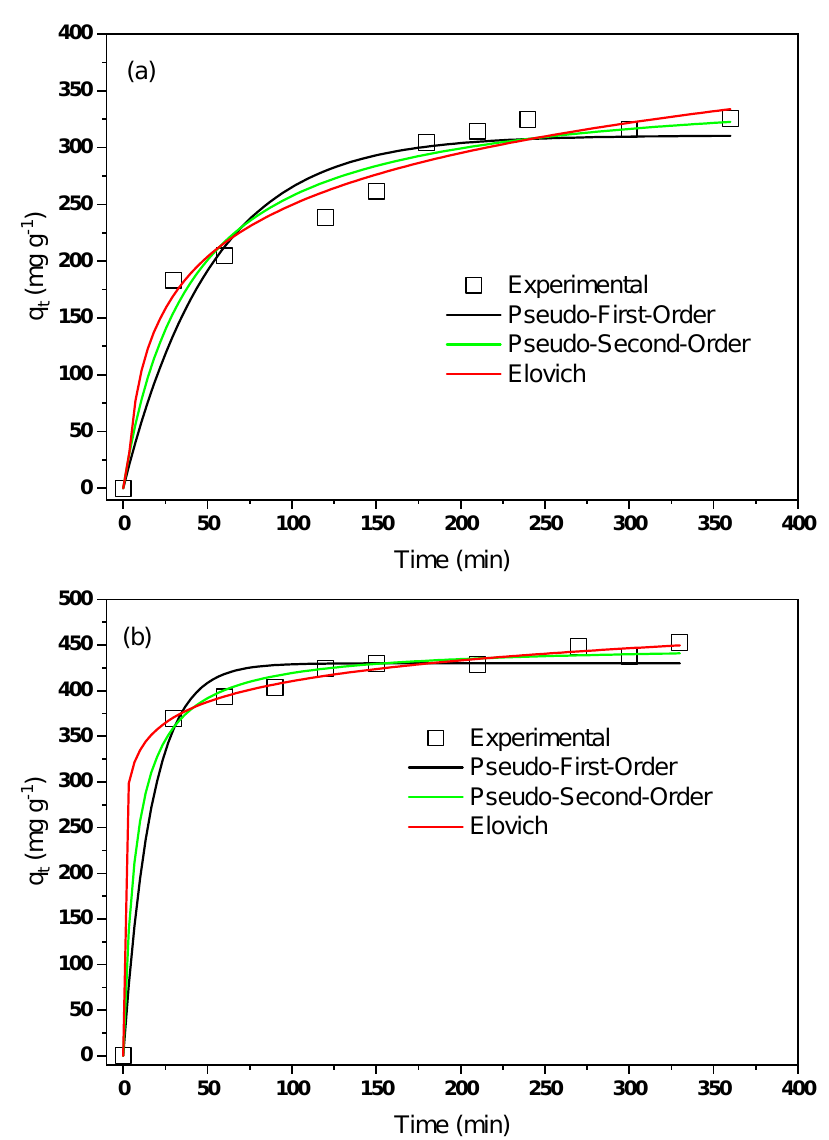
Figure 9. Influence of the contact time on RB dye adsorption using nonlinear fits in kinetic models ( a ) NaTiNT − 2NH and ( b ) NaTiNT −